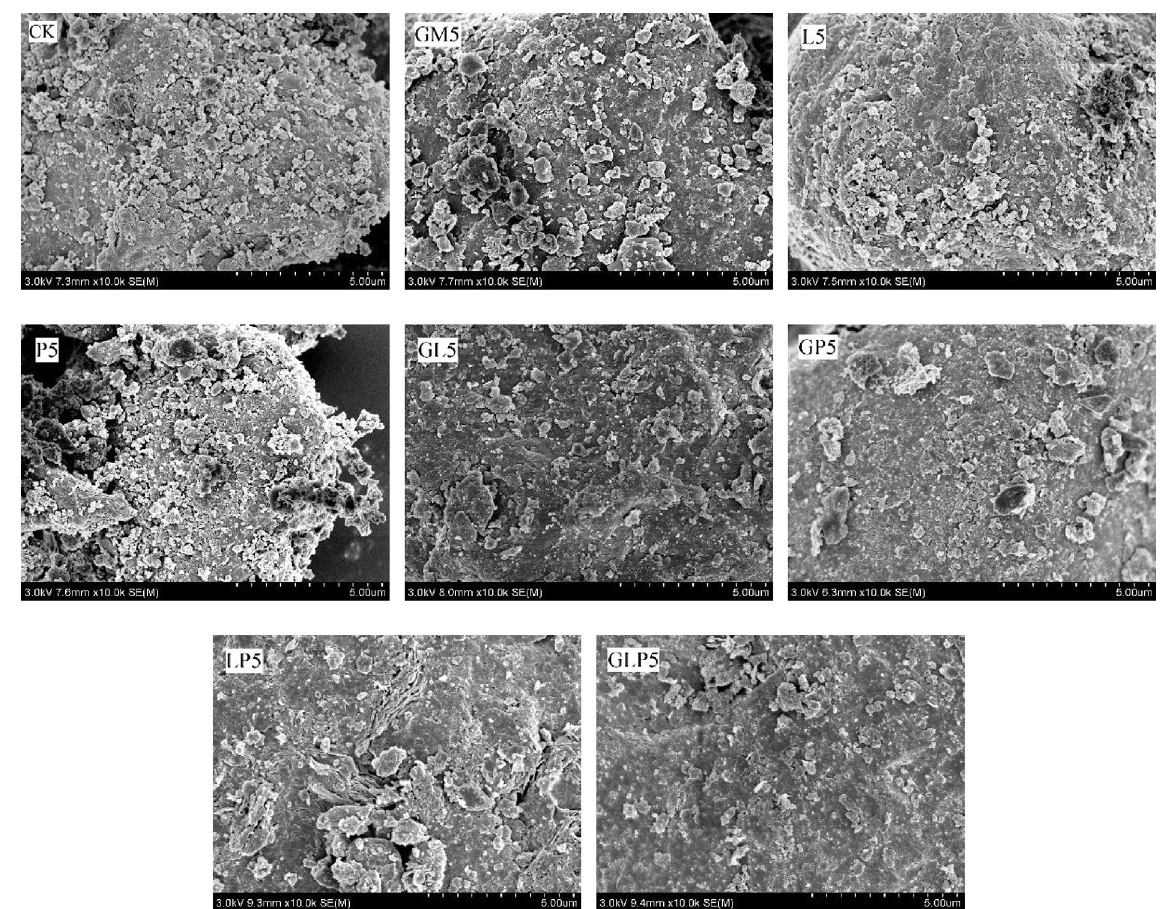
Figure 7. SEM images of fine sand soil particles before and after passivator treatments. (CK: control check, GM: goat manure, L: Ca(OH) 2 , P: Ca(H 2 PO 4 )·2H 2 O, GL: goat manure + Ca(OH) 2 , GP: goat manure + Ca(H 2 PO 4 )·2H 2 O, LP: Ca(OH) 2 + Ca(H 2 PO 4 )·2H 2 O, GLP: goat manure + Ca(OH) 2 + Ca(H 2 PO 4 )·2H 2 O; 1, 2, 5 represents the proportion of